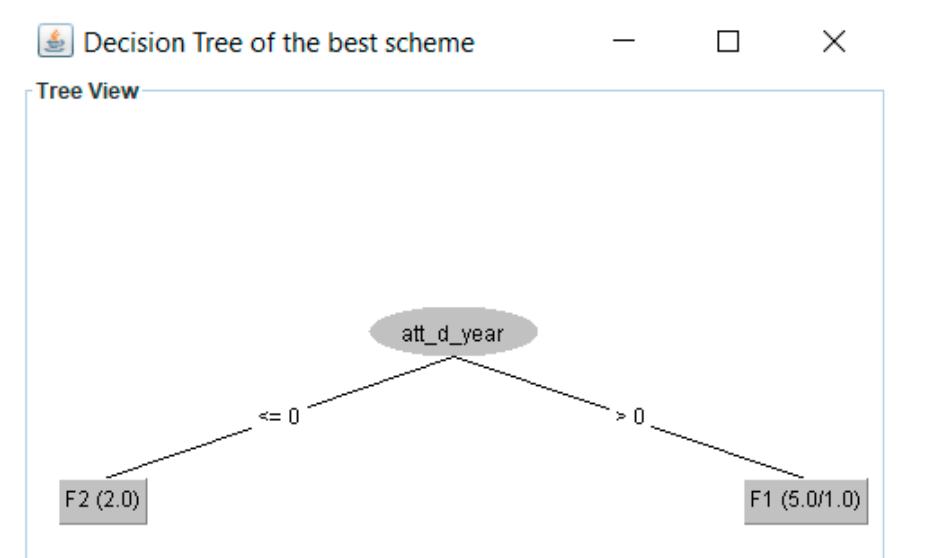
Figure 3. Decision tree of the best scheme (with better results for the evaluation metrics).